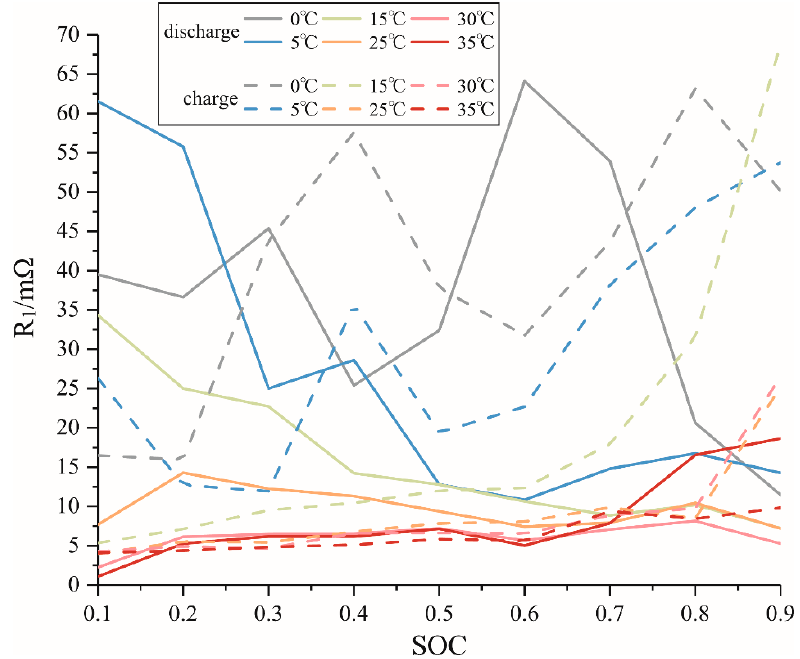
Figure 12. Evolution of the polarization resistance R 1 as a function of SOC at different temperatures in the range 0–35 °C.